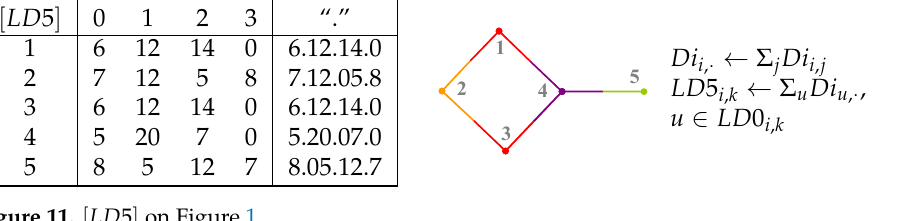
Figure 11. [ LD 5 ] on Figure 1.